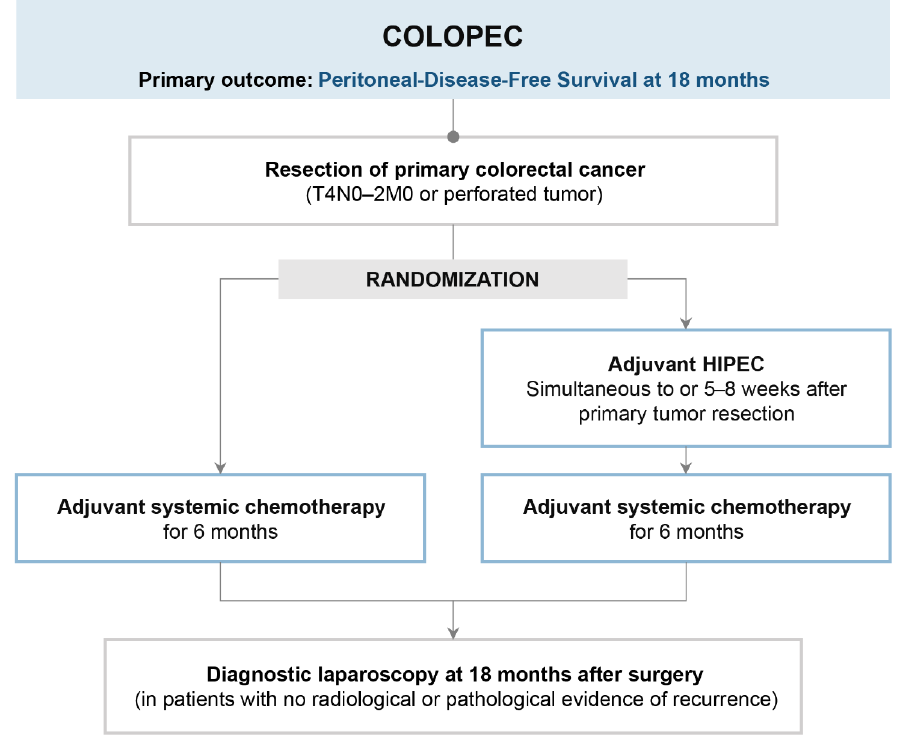
Figure 3. COLOPEC trial design.